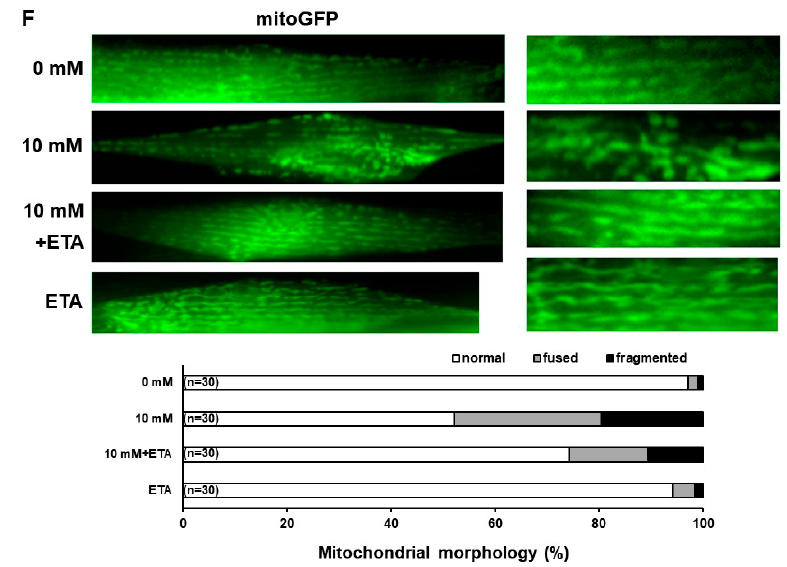
Figure 5. Supplementation with phosphoethanolamine (PE) or ethanolamine (ETA) mitigated the altered mitochondrial activity and morphology owing to ca ff eine intake in Caenorhabditis elegans . ( A ) Comparison of mitochondrial activity in the intestine of animals fed ca ff eine supplemented with PE with that of ca ff eine-fed animals using MitoTracker staining. The graph shows the relative levels of mitochondrial activity using ImageJ analysis. Statistical significance was calculated using one-way ANOVA. * p < 0.05. Error bars represent standard deviation (SD). ( B ) Comparison of mitochondrial morphology in the muscle cells of animals fed ca ff eine supplemented with PE with that of ca ff eine-fed animals using MitoTracker staining. The graph indicates the percentage of animals with mitochondria classified as tubular, intermediate, fragmented, swollen, or aggregated. ( C ) The e ff ect of ca ff eine intake with PE supplementation on mitochondrial morphology was analyzed in the transgenic strain SJ4103 expressing a mitochondrial-targeted GFP under the control of the muscle-specific myo-3 promoter. The graph indicates the percentage of animals with muscle mitochondria classified as normal, fused, or fragmented. ( D ) Myofilament abnormality owing to ca ff eine intake visualized using the MYO-3::GFP transgene. Representative fluorescent images are shown for both the ca ff eine-free diet condition (0 mM) and PE supplementation condition (PE), resulting in normal filament organization. The MYO-3::GFP abnormalities (aggregations) observed in ca ff eine-fed animals (10 mM) were restored by PE supplementation. The graph indicates the percentage of animals classified as having normal muscle or damaged muscle (aggregations) in the respective conditions. ( E ) Comparison of mitochondrial activity in the intestine of animals fed ca ff eine supplemented with ETA with that of ca ff eine-fed animals using MitoTracker staining. The graph shows the relative levels of mitochondrial activity using ImageJ analysis. Statistical significance was calculated using one-way ANOVA. *, p < 0.05. Error bars represent SD. ( F ) The e ff ect of ca ff eine intake with ETA supplementation on mitochondrial morphology was analyzed in the transgenic strain SJ4103 expressing a mitochondrial-targeted GFP under the control of the muscle-specific myo-3 promoter. The graph indicates the percentage of animals with muscle mitochondria classified as normal, fused, or fragmented.